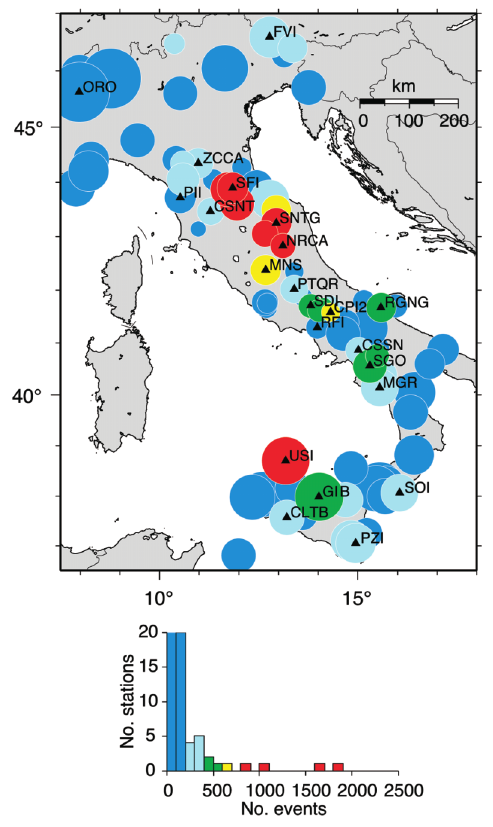
Fig. 11. Average S - P distance and number of non- located earthquakes, with the histogram of the no. of stations in bins of 100 events. The circle radius is proportional to the average S - P time (50 km radius for 10 s), whereas the colour (azure, cyan, green, yel- low, red) depends on the number of data at each sta- tion. Circles with more events lie higher. The his- togram adopts the same colour scheme of the circles, but the vertical scale is cropped at 20 stations for number of events less than